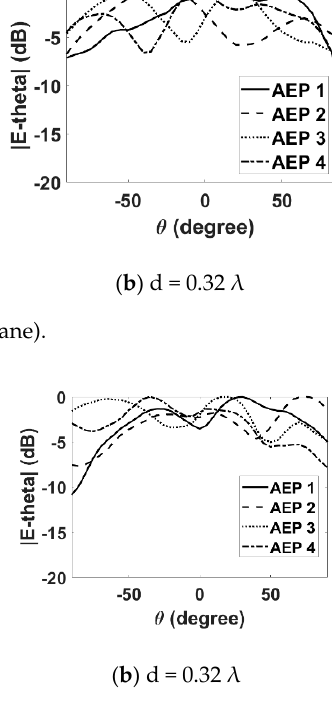
Figure 9. Measured active element patterns (H plane).